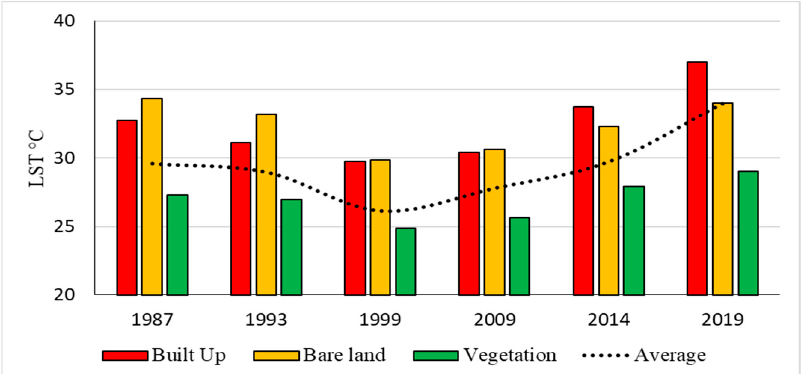
Figure 7. Average LST of the three main land use classes in the study area from 1987 to 2019 in °C.